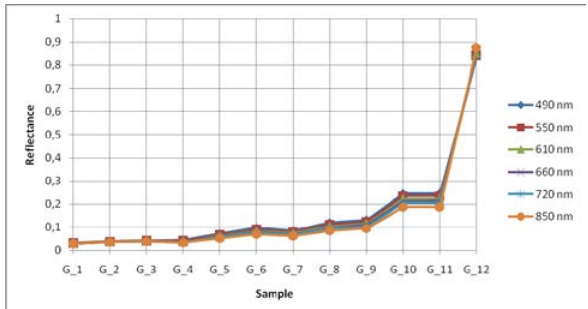
Figure 8. Spectral characteristics acquired from